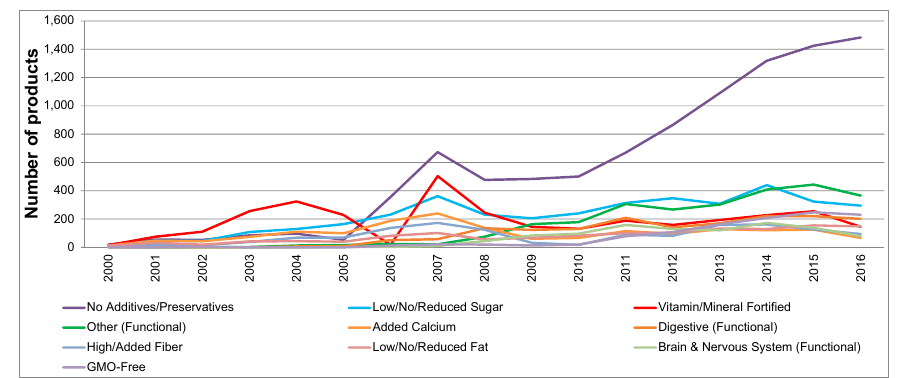
Figure 5. Number of launched products by top 10 health and nutrition claims during 2000–2016. Source: Own elaboration based on Mintel’s GNPD data.